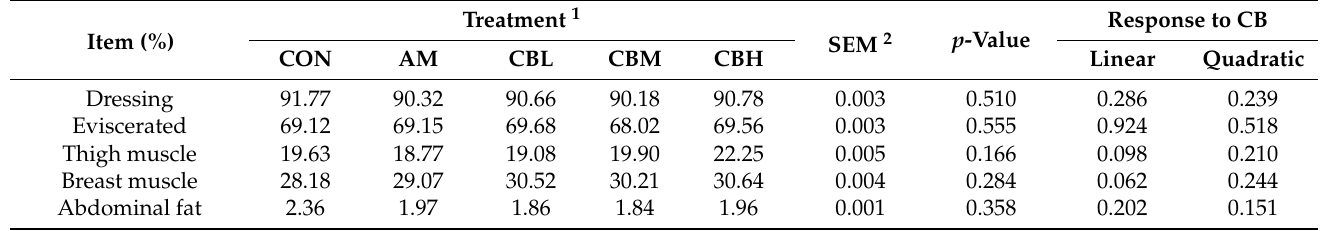
Table 2. The slaughter performance of broilers feed with C. butyricum